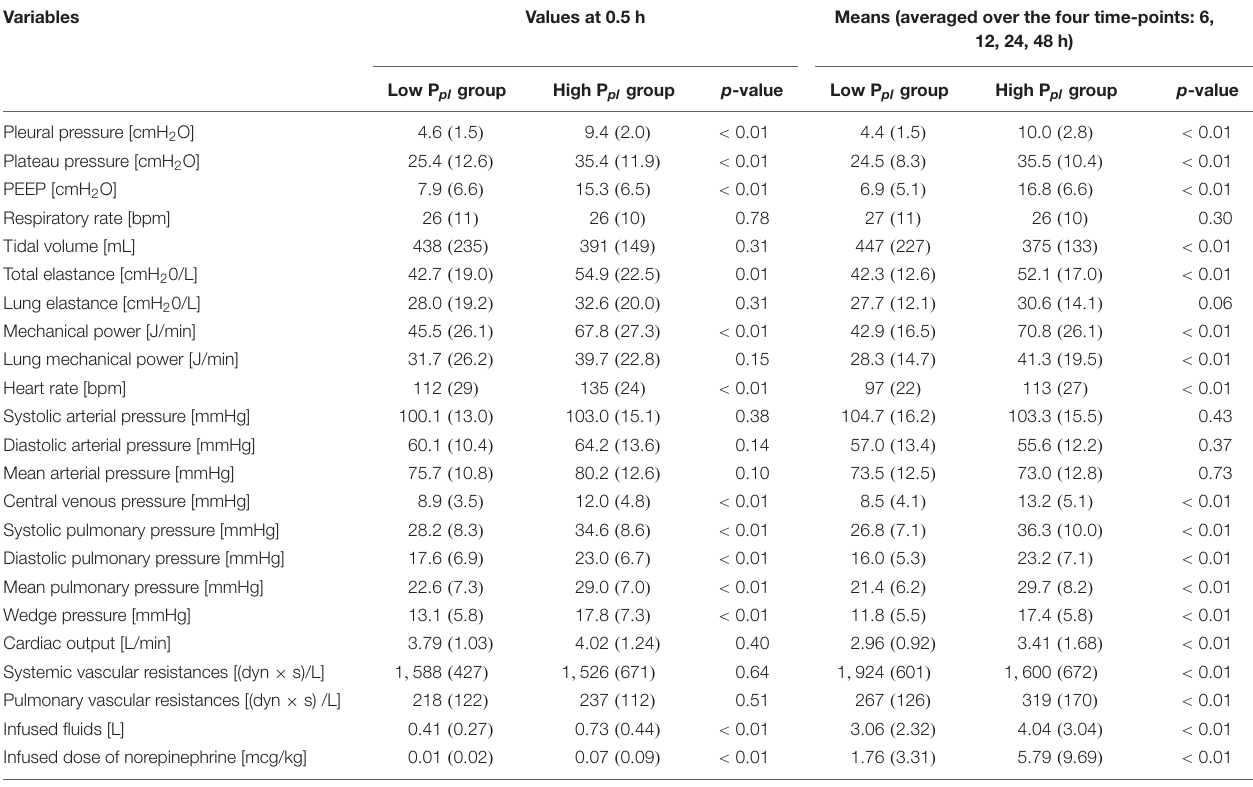
TABLE 1 | Respiratory mechanics and hemodynamics in high and low pleural pressure groups. Variables Values at 0.5 h Means (averaged over the four time-points: 6,